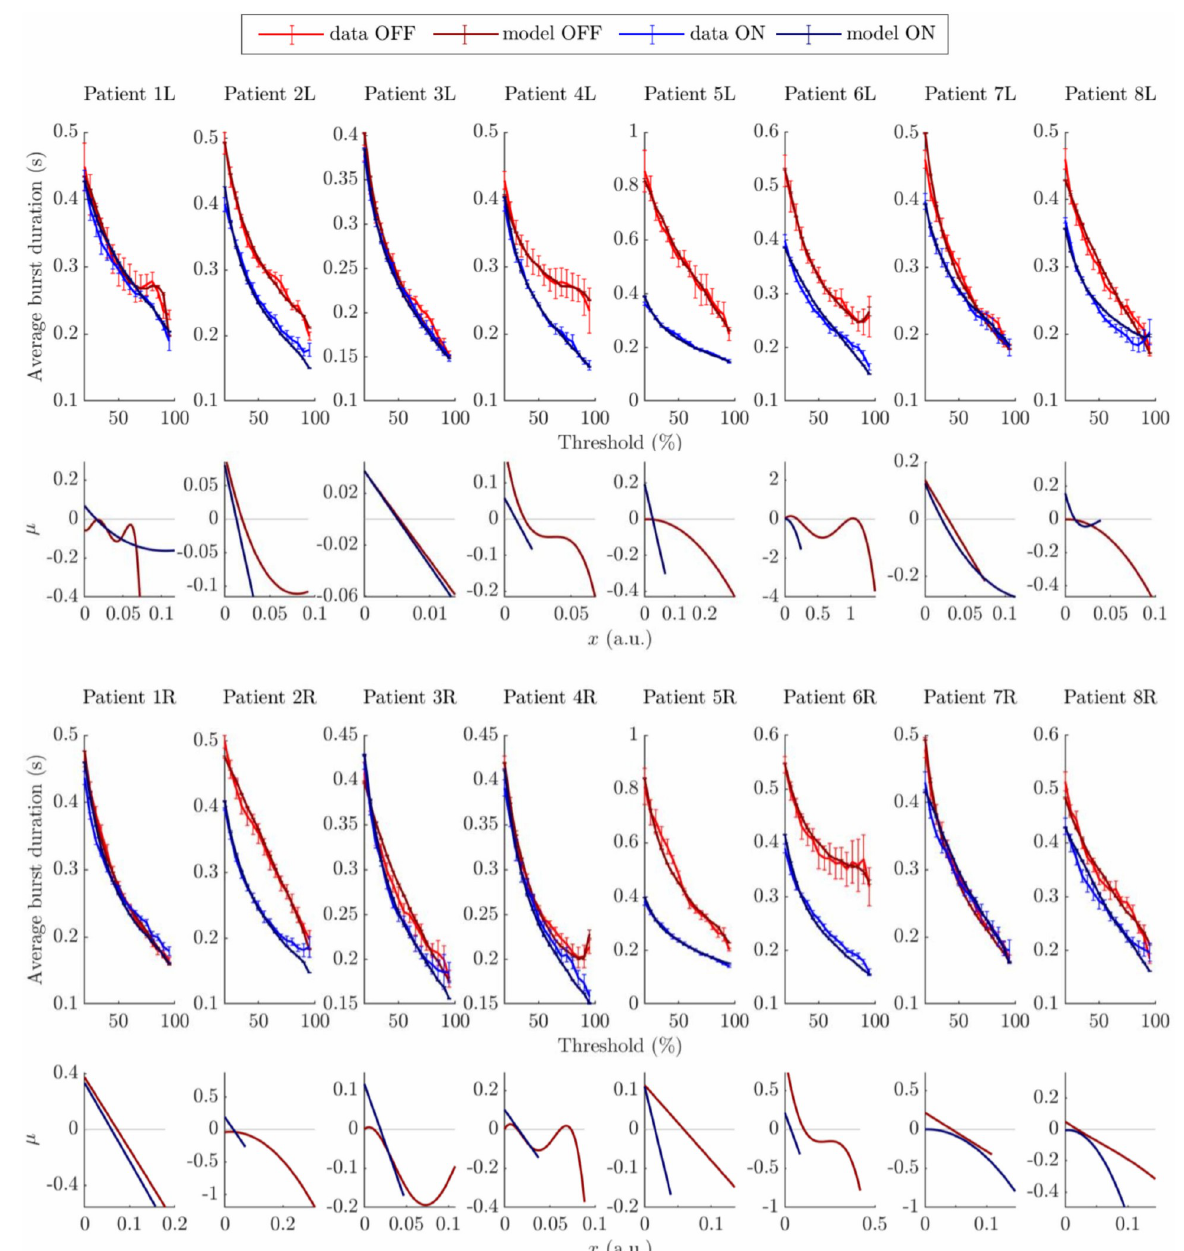
Fig 8. Envelope model fits to all datasets. The top two rows correspond to left hemispheres, the bottom two rows to right hemispheres, and each column corresponds to one patient. Patient’s average burst duration profiles and corresponding model fits are shown in the first and third rows (SEM error bars). The OFF state is represented in red for data, and in dark red for model fits. The ON state is represented in blue for data, and in dark blue for model fits. The drift functions ( μ ) of the fitted envelope models are shown in the second and fourth rows. The range of x values shown for each drift function corresponds to the range spanned by the corresponding model, and the light grey line represents μ = 0.